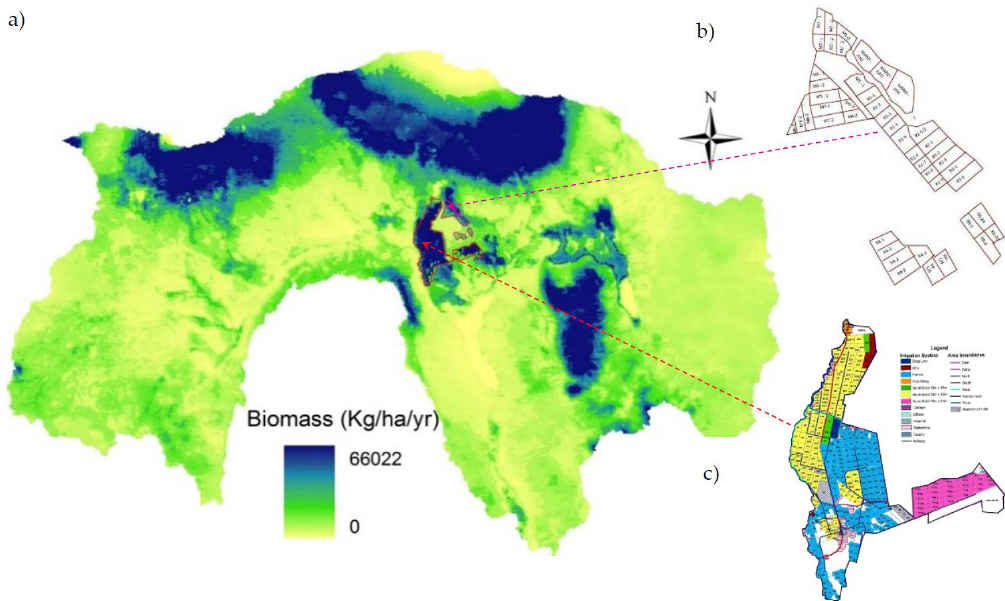
Figure 2. ( a ) Spatial variability of biomass growth in the Upper Pangani River Basin; ( b ) the Lower Moshi irrigation scheme; ( c ) the Tanzania Plantation Company (TPC) sugarcane irrigation scheme .